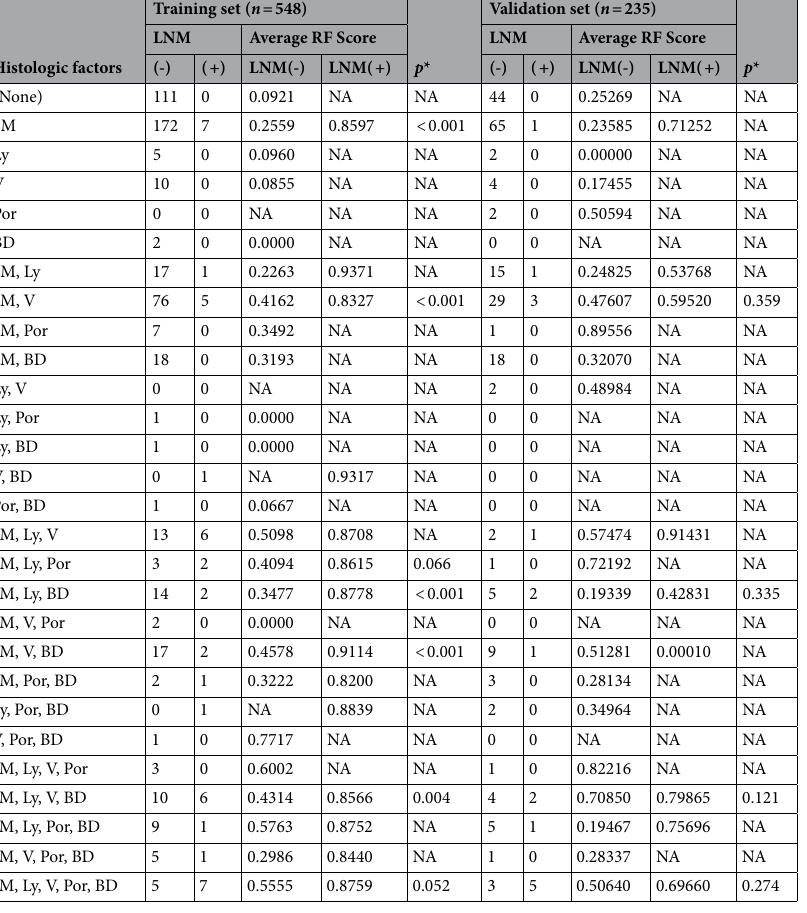
Table 3. Correlation between conventional histologic risk factors and RF scores. LNM, lymph node metastasis; RF, random forest; SM, deep submucosal invasion; Ly, lymphatic invasion; V, venous invasion; Por, poorly differentiated clusters; BD, high-grade tumor budding; NA, not applicable. *Student